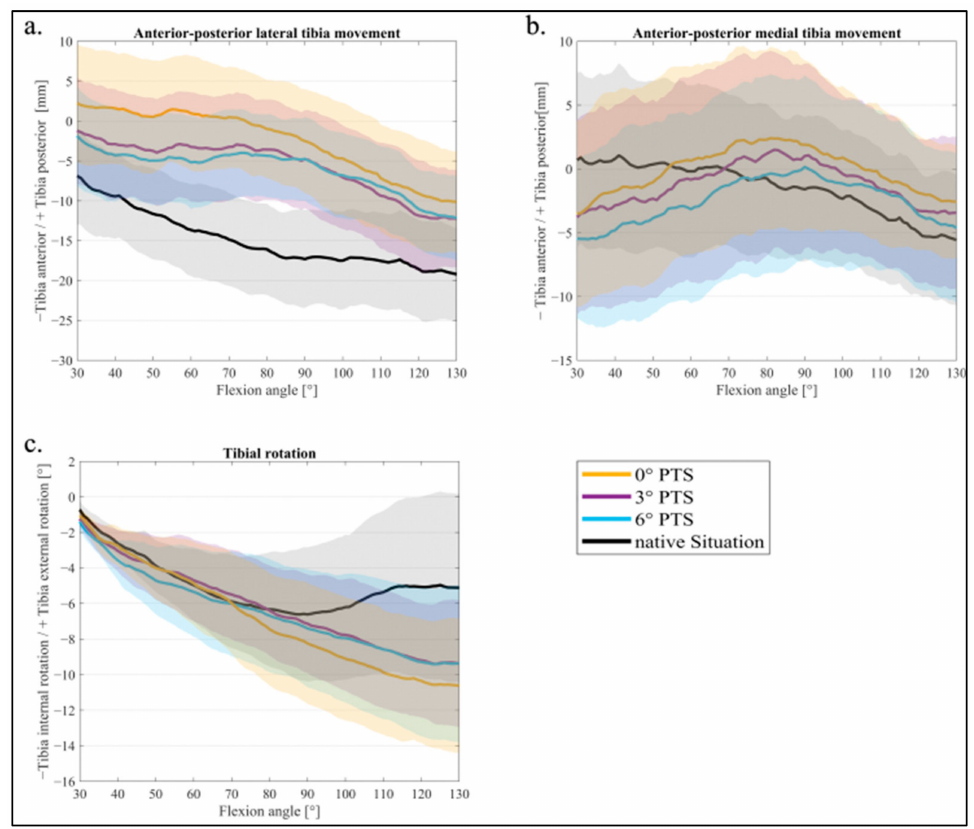
Figure 4. Mean values and 95% confidence interval of femorotibial kinematics: ( a ) anterior–posterior lateral tibia translation; ( b ) anterior–posterior medial tibia translation; ( c ) tibial rotation for 0 ◦ PTS (orange), 3 ◦ PTS (purple), 6 ◦ PTS (blue), and native situation